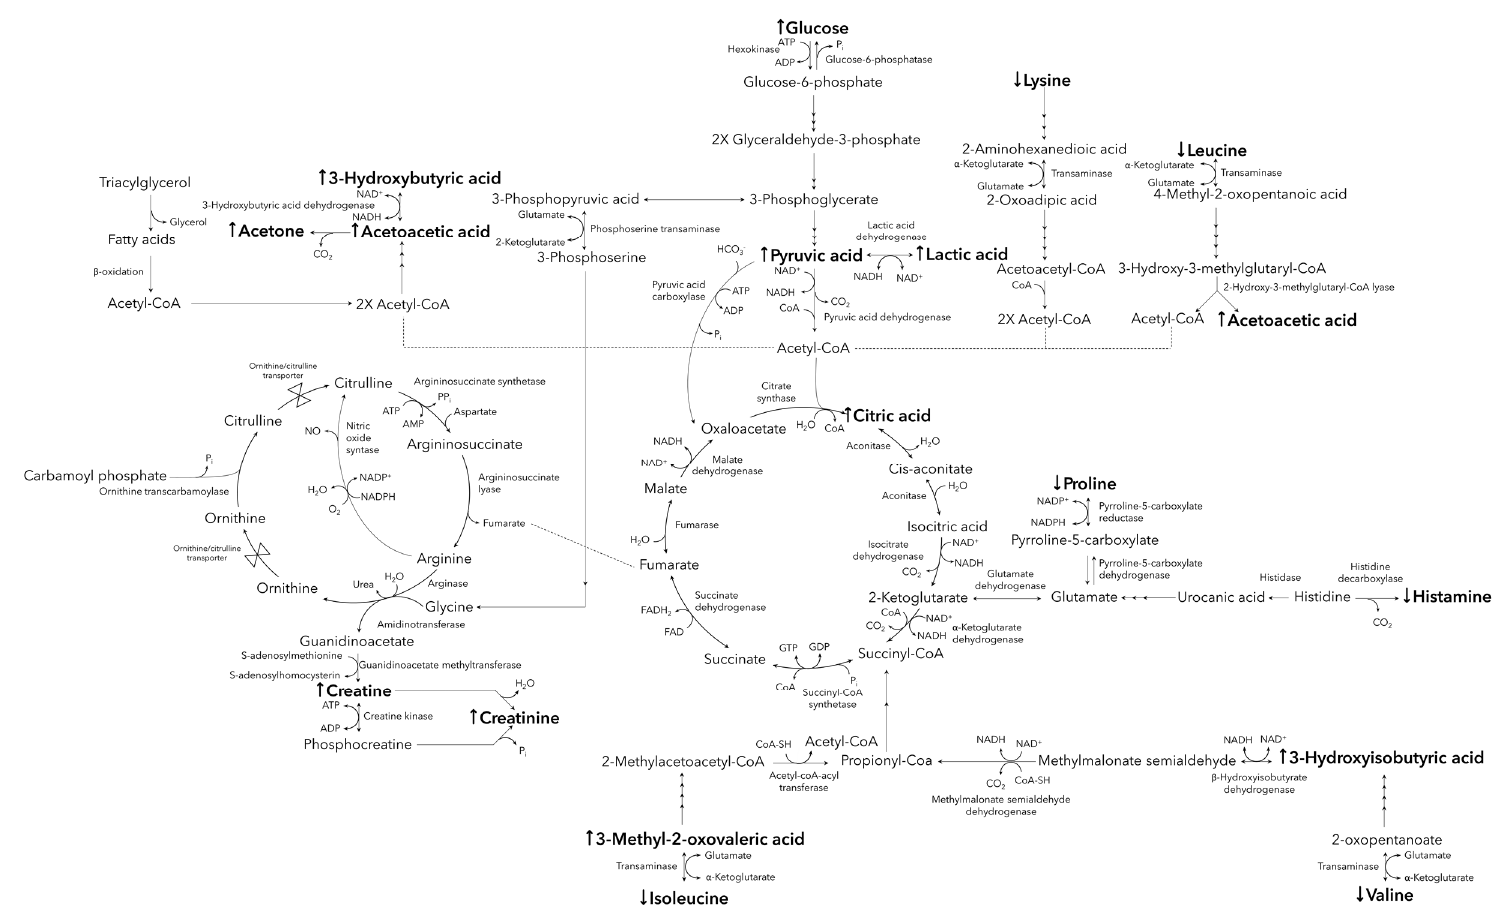
Figure 2. A schematic description of the marathon-induced metabolic changes, showing increased ( ↑ ) and decreased ( ↓ ) concentrations of significantly altered metabolites in the post-marathon samples ( in bold text ) are indicated relative to the pre-marathon values. ATP adenosine triphosphate, ADP adenosine diphosphate, AMP adenosine monophosphate, NAD + nicotinamide adenine dinucleotide, NADH reduced nicotinamide adenine dinucleotide, NADP + nicotinamide adenine dinucleotide phosphate, NADPH reduced nicotinamide adenine dinucleotide phosphate, P i inorganic phosphate, CoA coenzyme A, FAD flavin adenine dinucleotide, FADH 2 reduced flavin adenine dinucleotide, GTP guanosine triphosphate, GDP guanosine diphosphate.